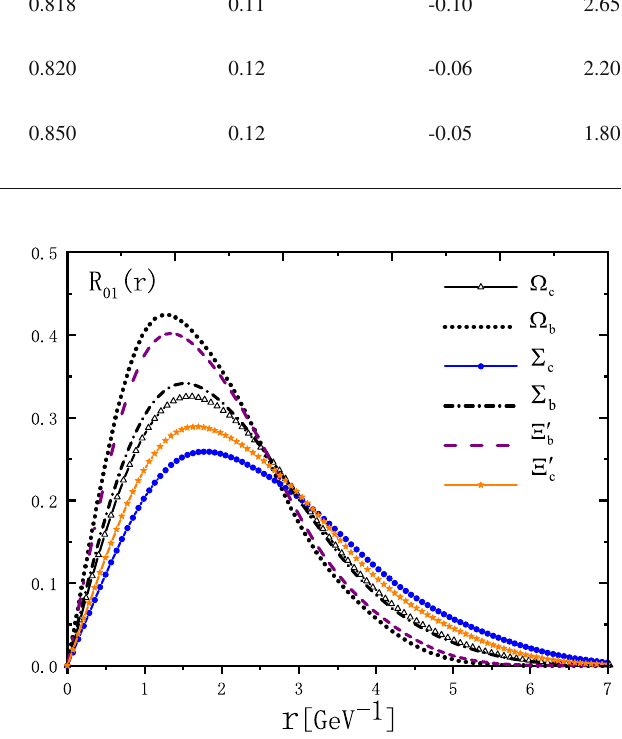
Fig. 3 The P-wave radial wavefunction R nL ( r ) with n = 0 and L = 1, numerically solved from Eq. (C8), with the inputs in Table 9